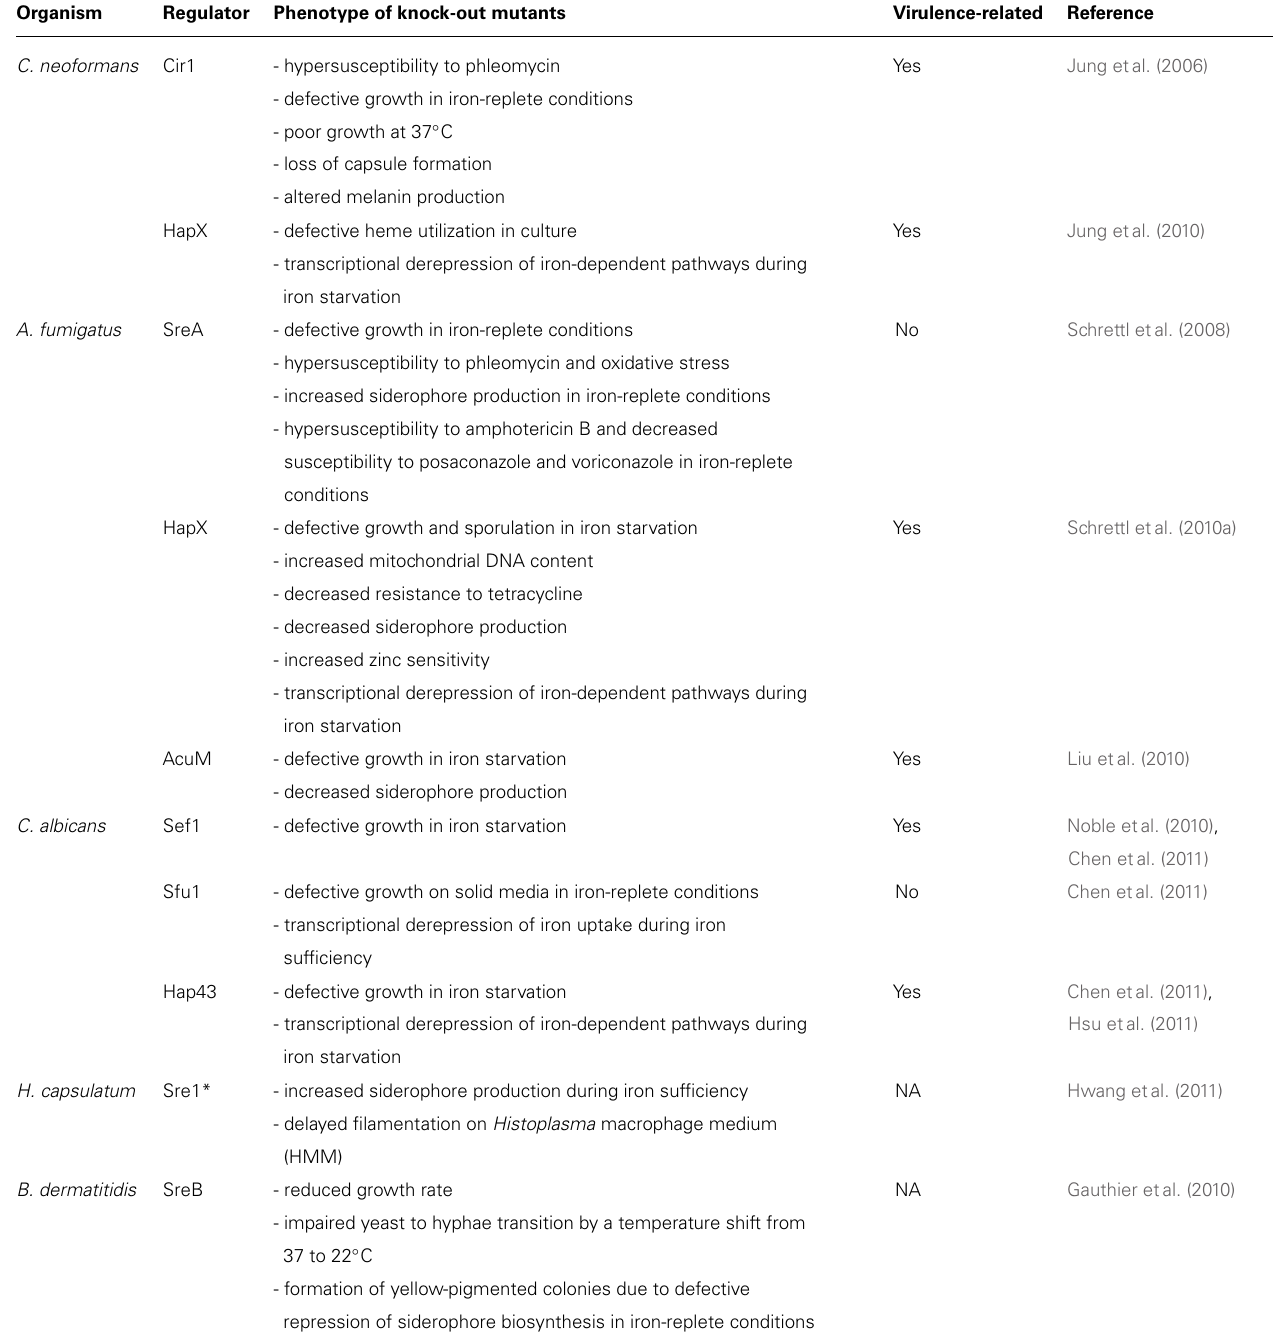
Table 2 | Phenotypes key regulatory gene null mutants for iron